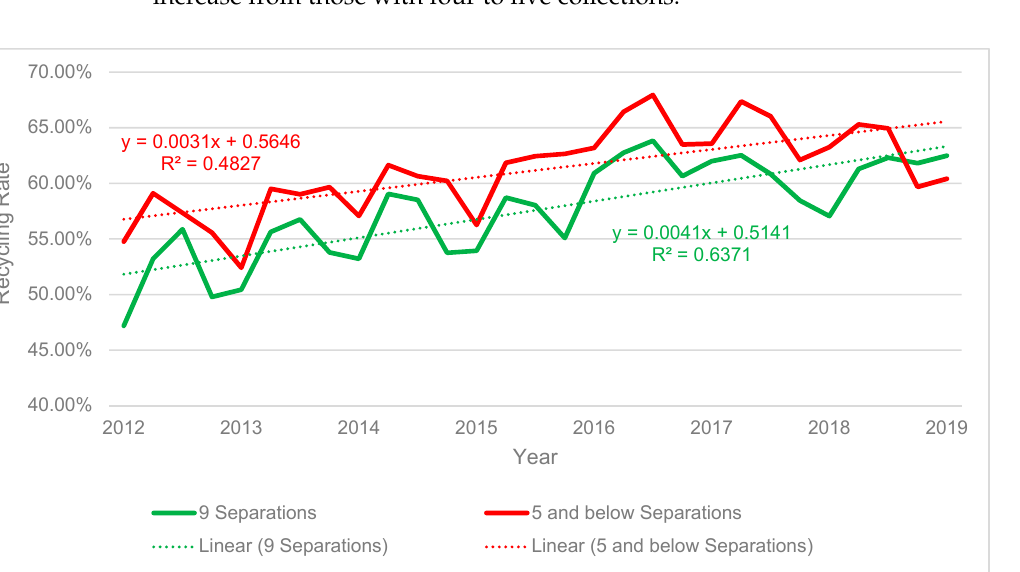
Figure 6. Trends in waste treatment for WalesSource: WasteDataFlow.